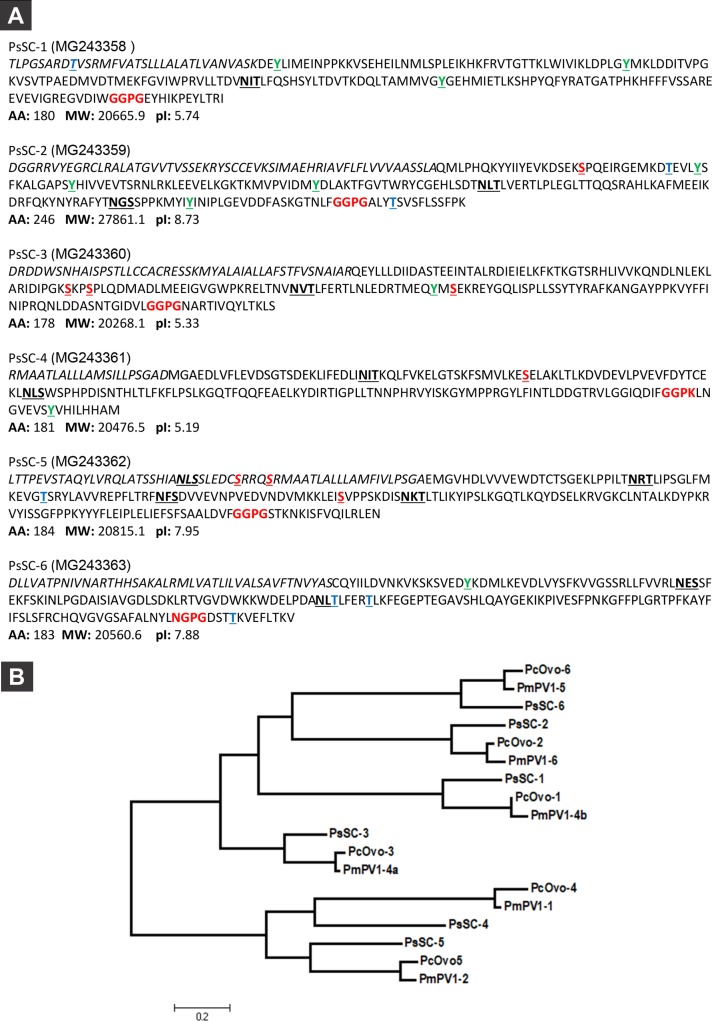
A, Deduced amino acid sequences of PsSC subunits. The putative signal sequences are in italics. Potential phosphorylation sites are underlined in bold green (Tyr), bold red (Ser) and bold blue (Thr). Potential N-glycosylation sites (NXS/T) are underlined and in bold. Conserved sequence in bold red. AA: number of residues, MW: molecular weight and pI: isoelectric point of the subunit mature forms. B, Phylogenetic analysis of the major perivitelins of P. scalaris, P. canaliculata and P. maculata. Tree was constructed by the Maximum Likelihood method and drawn to scale, with branch lengths measured in the number of substitutions per site. All positions containing gaps and missing data were eliminated. There were a total of 165 positions in the final dataset.